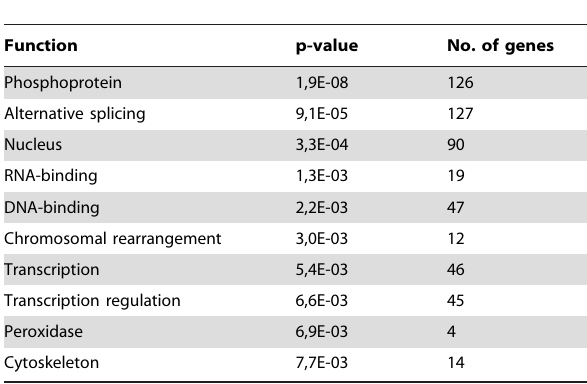
associated with genes differentially modulated in IFN a 2 pre- treated macrophages infected or not with HIV-1.